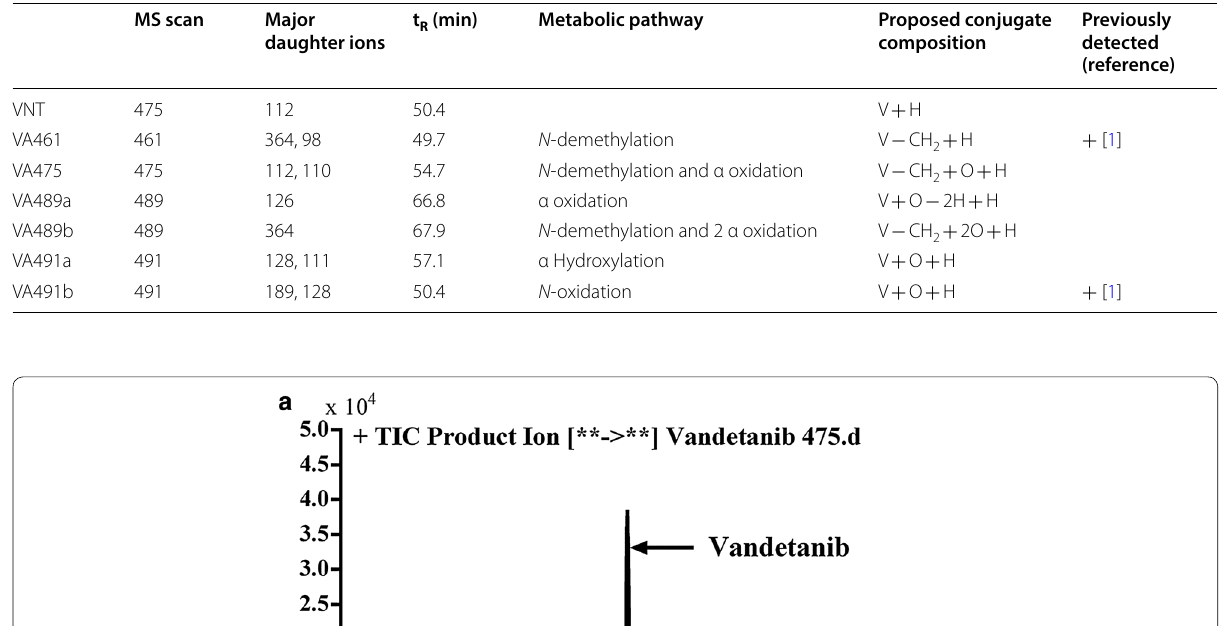
group from the N -methyl piperidine and oxidation of α-carbon in the ring which matched with the other daughter ion at m/z of 110 (Scheme